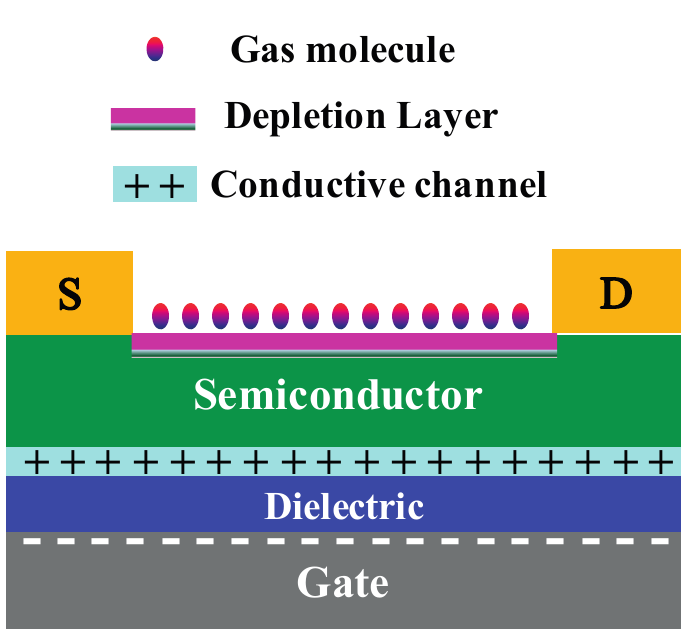
Figure 2. Schematic image of the interaction of the adsorbed gas molecules with